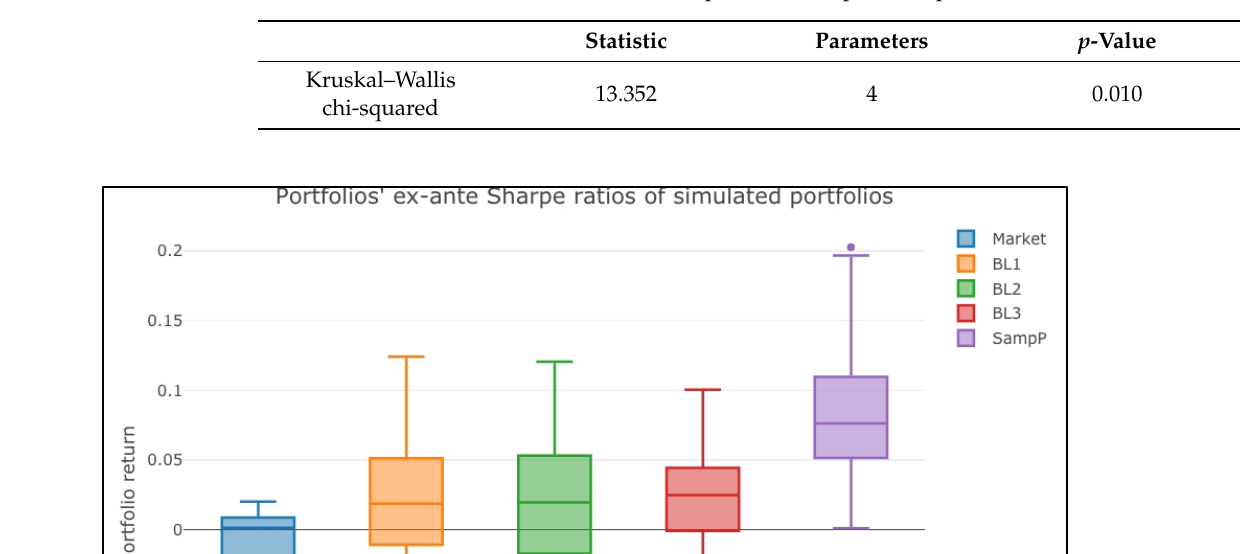
Table 8. Kruskal–Wallis test of the simulated portfolios’ ex-post Sharpe ratios.